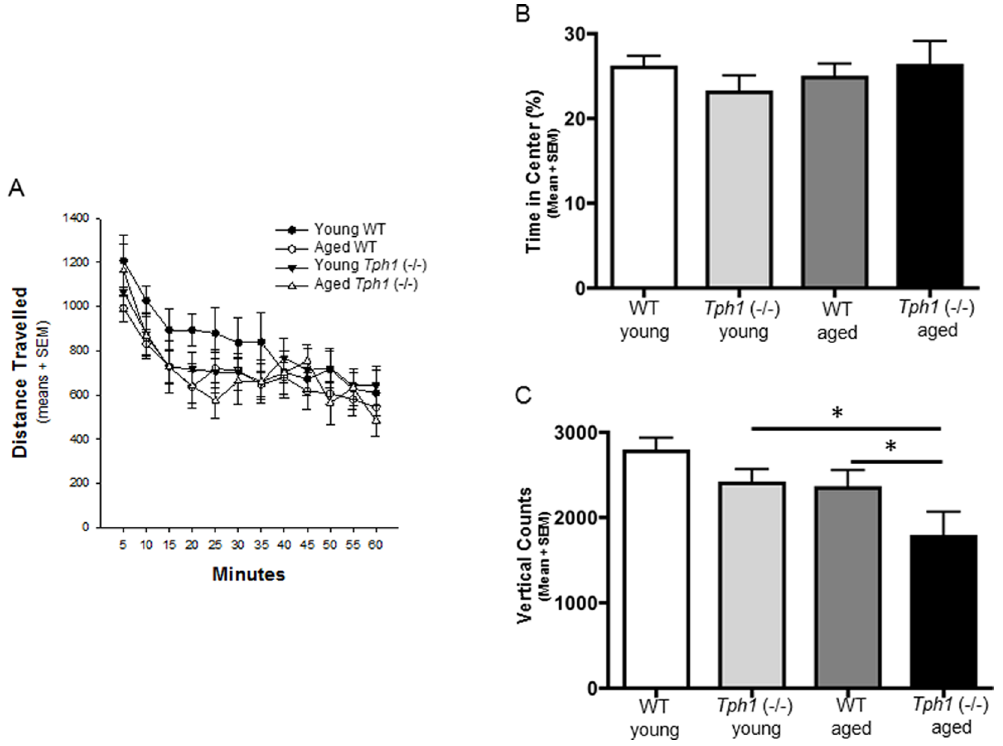
Figure 2. Aged Tph1 ( 2 / 2 ) demonstrate significantly fewer vertical rearing counts compared to WT mice. Distance traveled in the open field chamber (A) and time spent in the center of the chamber (B) was similar between WT and Tph1 ( 2 / 2 ) mice. Aged Tph1 2 / 2 mice have significantly fewer vertical counts as assessed by 2-way ANOVA; P , 0.05 (C). Post hoc analysis revealed that there was a significant difference between aged WT and Tph1 ( 2 / 2 ) (* P , 0.05) and a significant difference between young and aged Tph1 ( 2 / 2 ) mice (* P , 0.05).